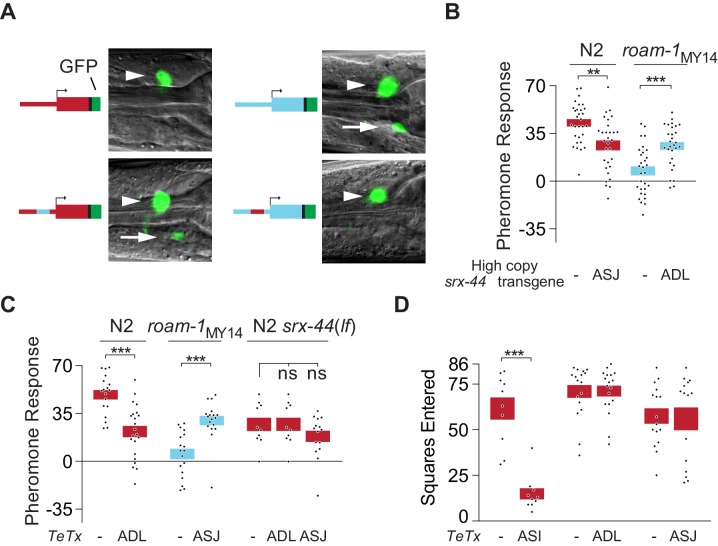
srx-44 site of expression determines whether it potentiates (ADL) or suppresses (ASJ) behavioral response to icas#9.(A) Expression of GFP from srx-44 reporter genes. Images show overlaid fluorescence and differential interference contrast images of the anterior ganglion, with anterior at the left and dorsal up. Arrowheads indicate ADL, arrows indicate ASJ. Cartoons show transgenes tested in each image. Top left = Psrx-44(N2)::GFP; Top right = Psrx-44(MY14)::GFP. Bottom left = Psrx-44(N2 distal promoter/MY14proximal promoter)::GFP; Bottom right = Psrx-44(MY14 distal promoter/N2 proximal promoter)::GFP. (B) Transgenes expressing srx-44 under ASJ- or ADL-specific promoters oppositely affect pheromone responses. (C) Tetanus toxin light chain (TeTx) inhibition of neurotransmitter and neuropeptide release from ASJ or ADL affects icas#9 sensitivity in an srx-44 dependent manner. (D) TeTx inhibition of ASI, but not ADL or ASJ, reduces exploration on pheromone-free control plates, expressed as mean squares entered ± SEM. Boxes indicate the mean ± SEM. Box color indicates genotype at the roam-1 locus (Red = N2; Blue = MY14). All data presented as mean ± SEM. ***p<0.001,**p<0.01, ns = not significant by t test (B, C- N2 and roam-1MY14, D) or by ANOVA with Dunnett correction (C- N2 srx-44(lf)).DOI:
http://dx.doi.org/10.7554/eLife.21454.00810.7554/eLife.21454.009Figure 4—source data 1.Individual exploration assays in Figure 4B–D.